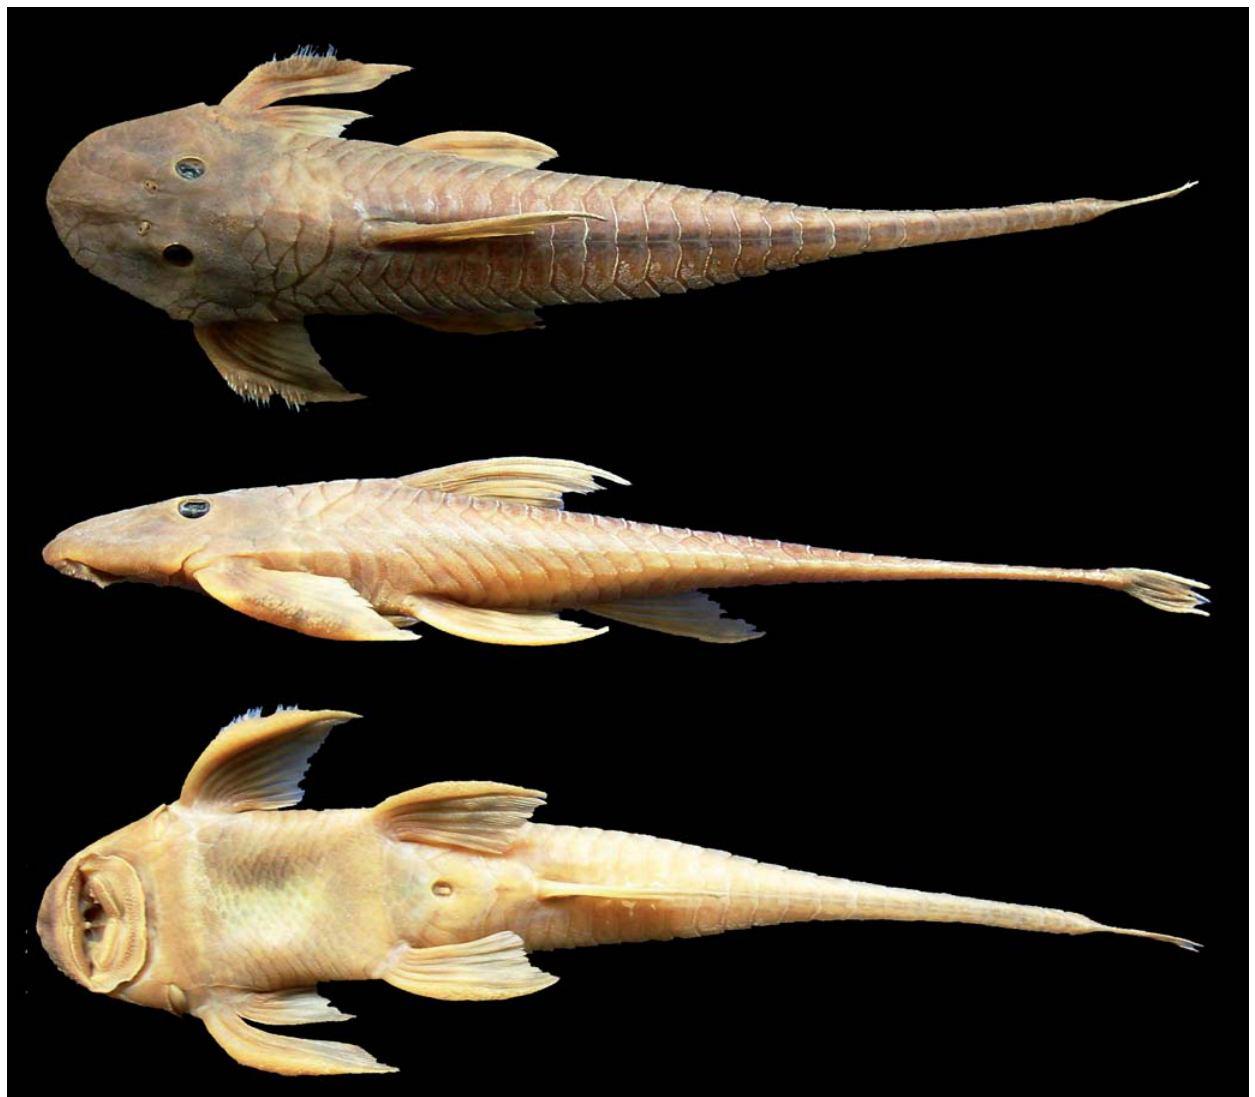
Fig. 8. Lamontichthys avacanoeiro , new species, MNRJ 32795, 150.5 mm SL, holotype. Dorsal, lateral and ventral